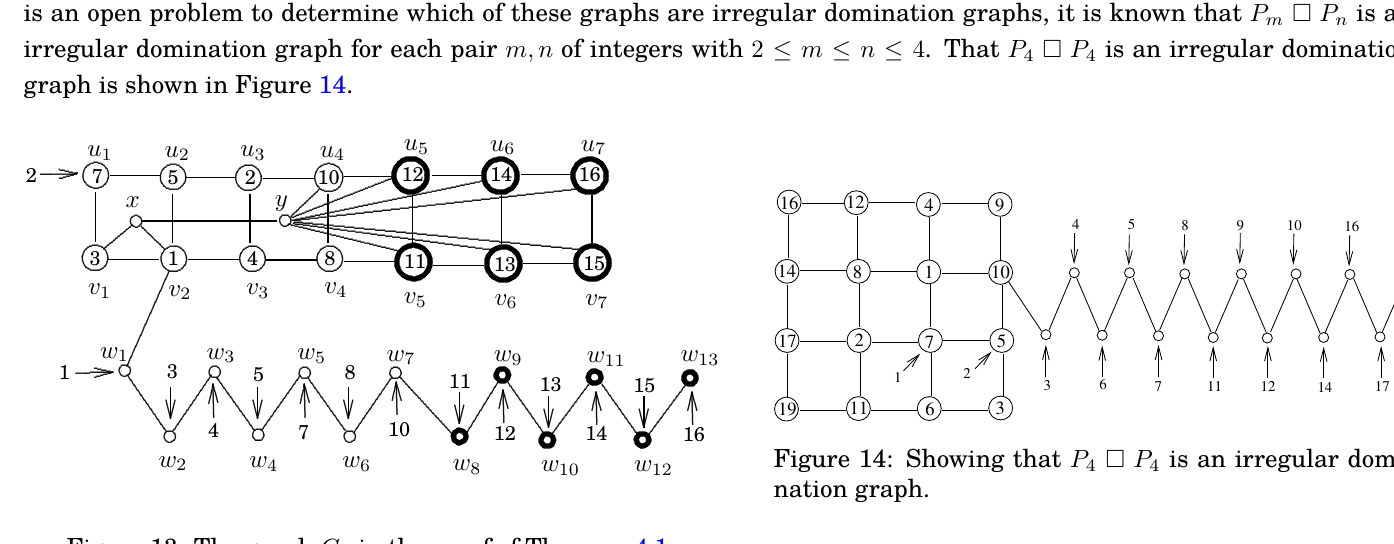
in the proof of Theorem 4.1. 7